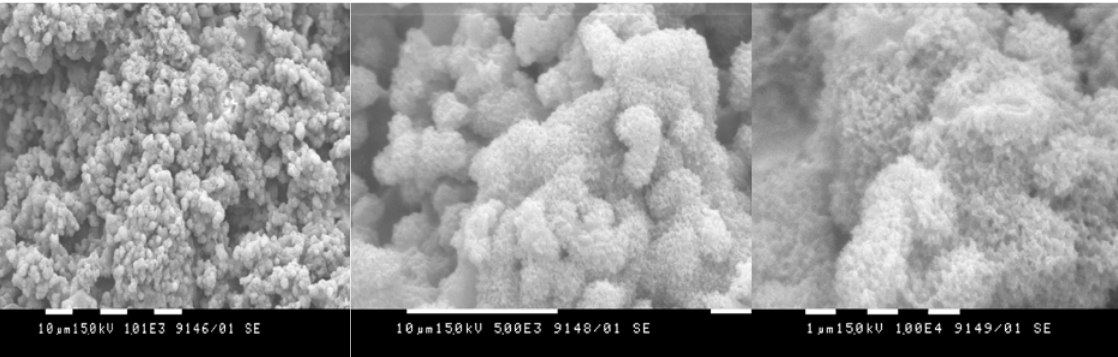
Figure 9. SEM micrographs of 25G:75CPS/W (wt.%) after in vitro test in 1.5 SBF for 3 days at different magnification